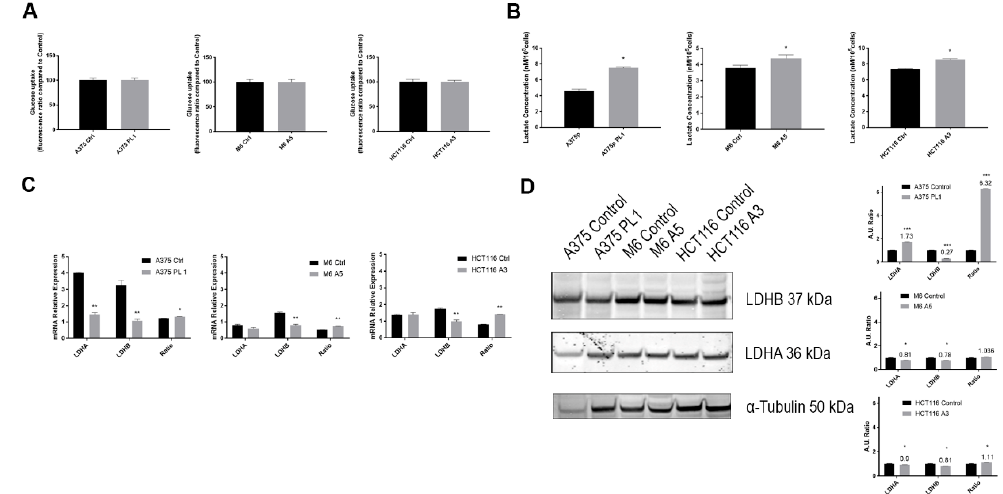
Figure 4. ( A ) Quantification of the fluorescence probe (2-NBDG) uptake through flow cytometer analysis ( n = 3). ( B ) Lactate production in conditioned media collected after 24 h ( n = 5). ( C ) Total RNA isolated was subjected to qPCR analysis of LDHA and LDHB expression. The ratio represents the LDHA/LDHB expression ( n = 3). ( D ) Immunoblot analysis of total cell lysates in order to determine the expression levels of LDHA and LDHB. Expression levels were checked by loading equal amounts of total protein. Densitometry analysis was performed using ImageJ software ( n = 3). Data are presented as mean ± SD. * p < 0.05; ** p < 0.01; *** p < 0.001 (Student’s test).